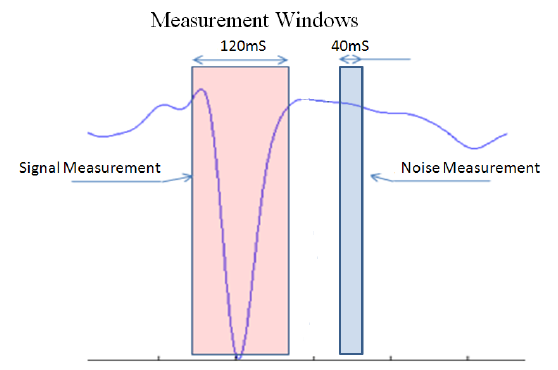
Figure 1. Signal-to-noise ratio (SNR) measurement windows.